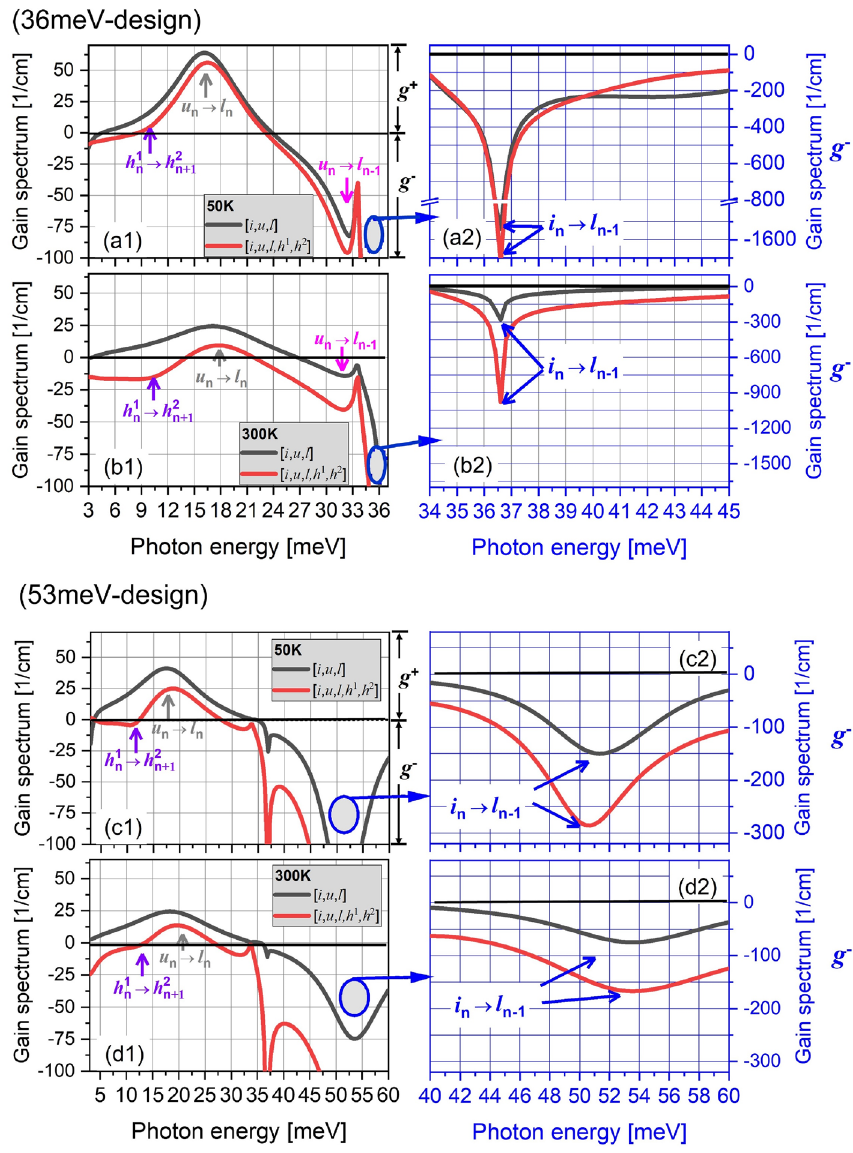
Figure 5. Gain spectrums in cases of a small scale [ i , u , l ] (black curves) and a full scale [ i , u , l , h 1 , h 2 ] (red curves) in both designs at 50 K ( a1 , c1 ) and 300 K ( b1 , d1 ). The exact transitions between subbands pairs are labeled by different color arrows in the spectrums. The gain is marked as g + , and the absorption is marked as g − . The exact absorption area near the depopulation energy is enlarged in plots ( a2 , b2